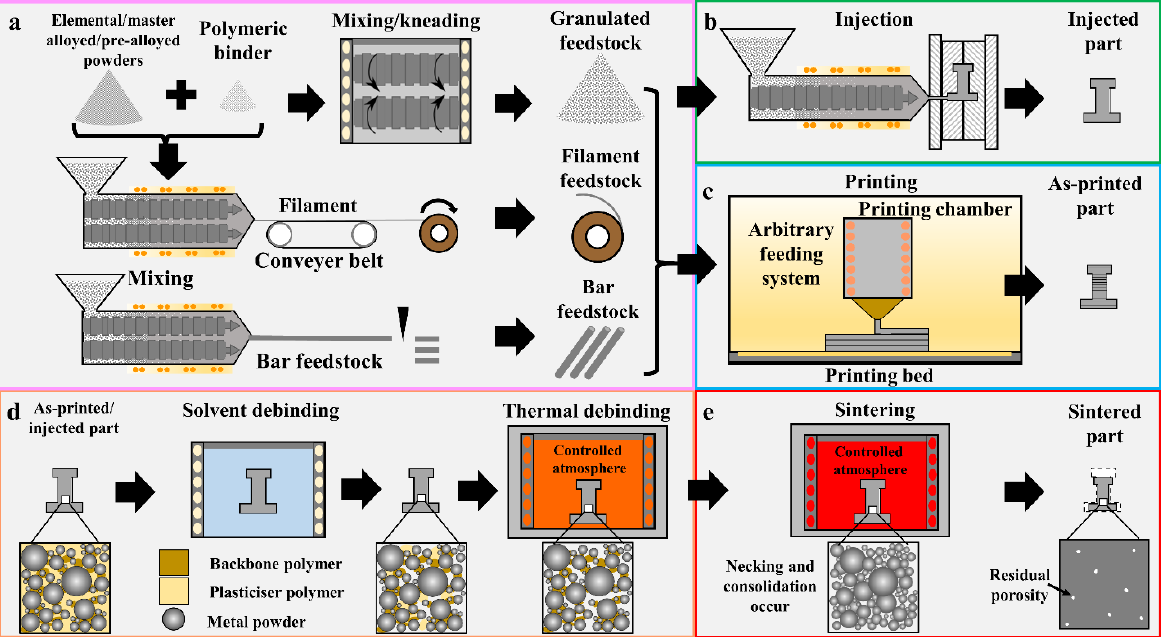
Figure 2. Comparison of material extrusion additive manufacturing of metal ( a , c , d , e ) and metal in- jection moulding ( a , b , d , e ).